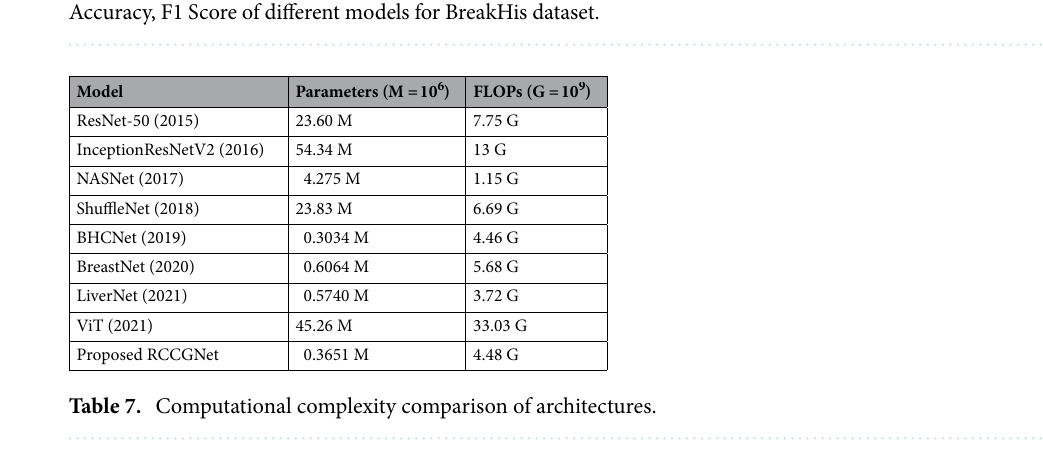
Figure 7. Box plot: ( a , b ) accuracy, F1 Score of different models for proposed KMC kidney dataset. ( c , d ) Accuracy, F1 Score of different models for BreakHis dataset.